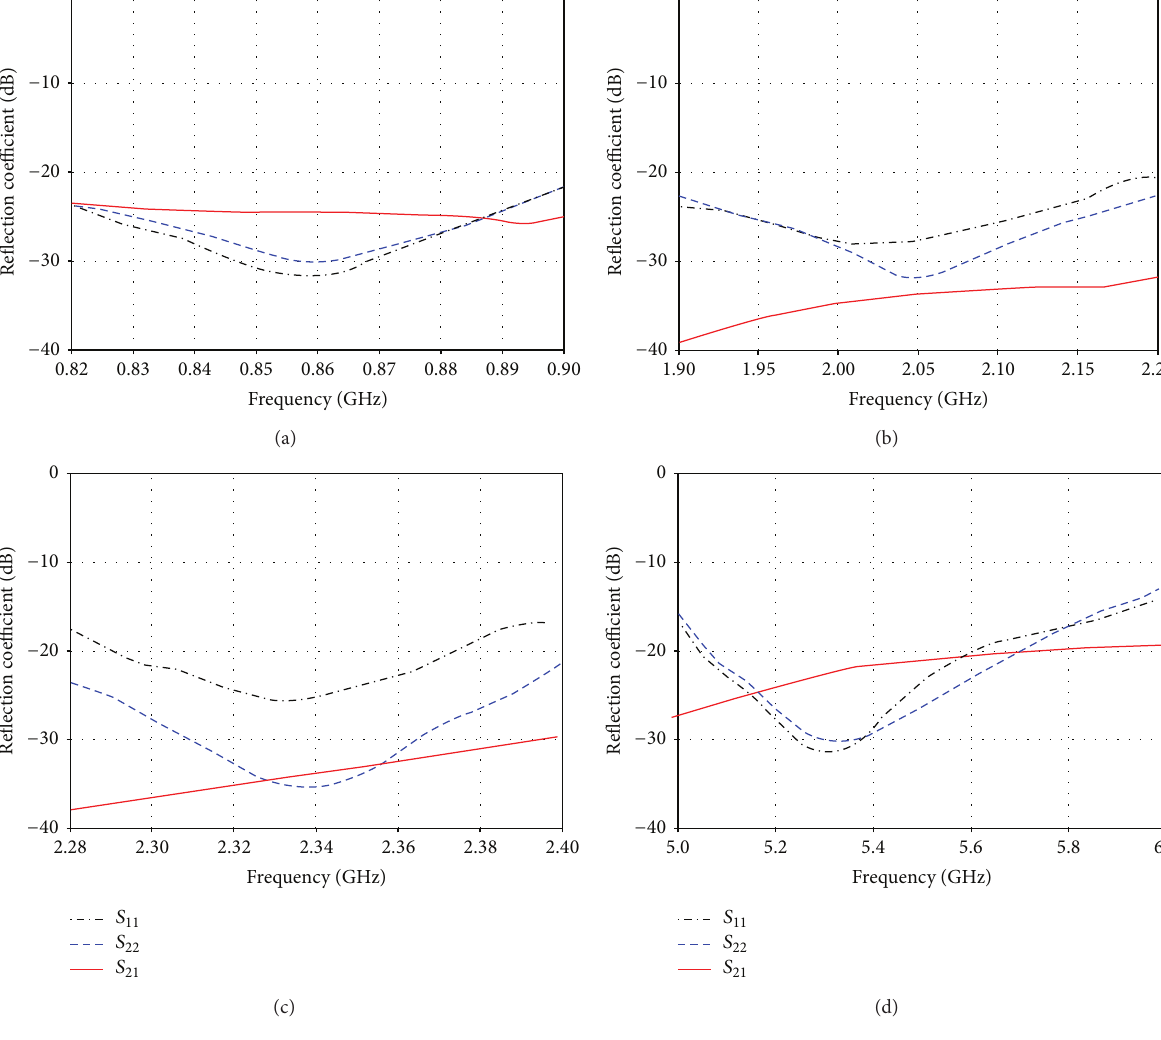
RX, and the spacing for Band 3 is 0.98 𝜆 0 for TX and RX. Thus Band 1 array is designed with array spacing of 250 mm (0.73 𝜆 0 for TX and 0.70 𝜆 0 for RX). Band 4 array is designed with array spacing of 42.5 mm, which is 0.78 𝜆 0 for TX and RX.